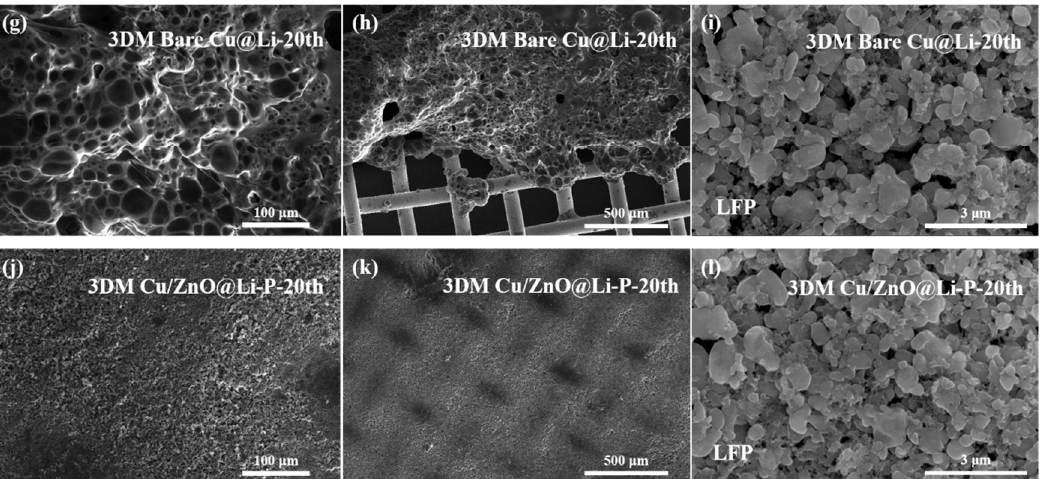
Figure 6. ( a ) Rate capability of the full cell with 3DM Cu@Li and 3DM Cu/ZnO@Li-P composite anode at different rates ranging from 0.1 to 2 C. ( b , c ) Voltage profiles during the rate testing at different current density. ( d ) Cycling performance of full cells with 3DM Cu@Li and Cu/ZnO@Li-P composite anode at 1 C with three activation cycles at 0.1 C in the beginning. EIS curves of two current collectors on lithium-free anodes: ( e ) before cycling, ( f ) after 20 cycles at 1 C. SEM images of ( g , h ) 3DM Cu@Li composite anode and ( j , k ) 3DM Cu/ZnO@Li-P composite anode after 20 cycles